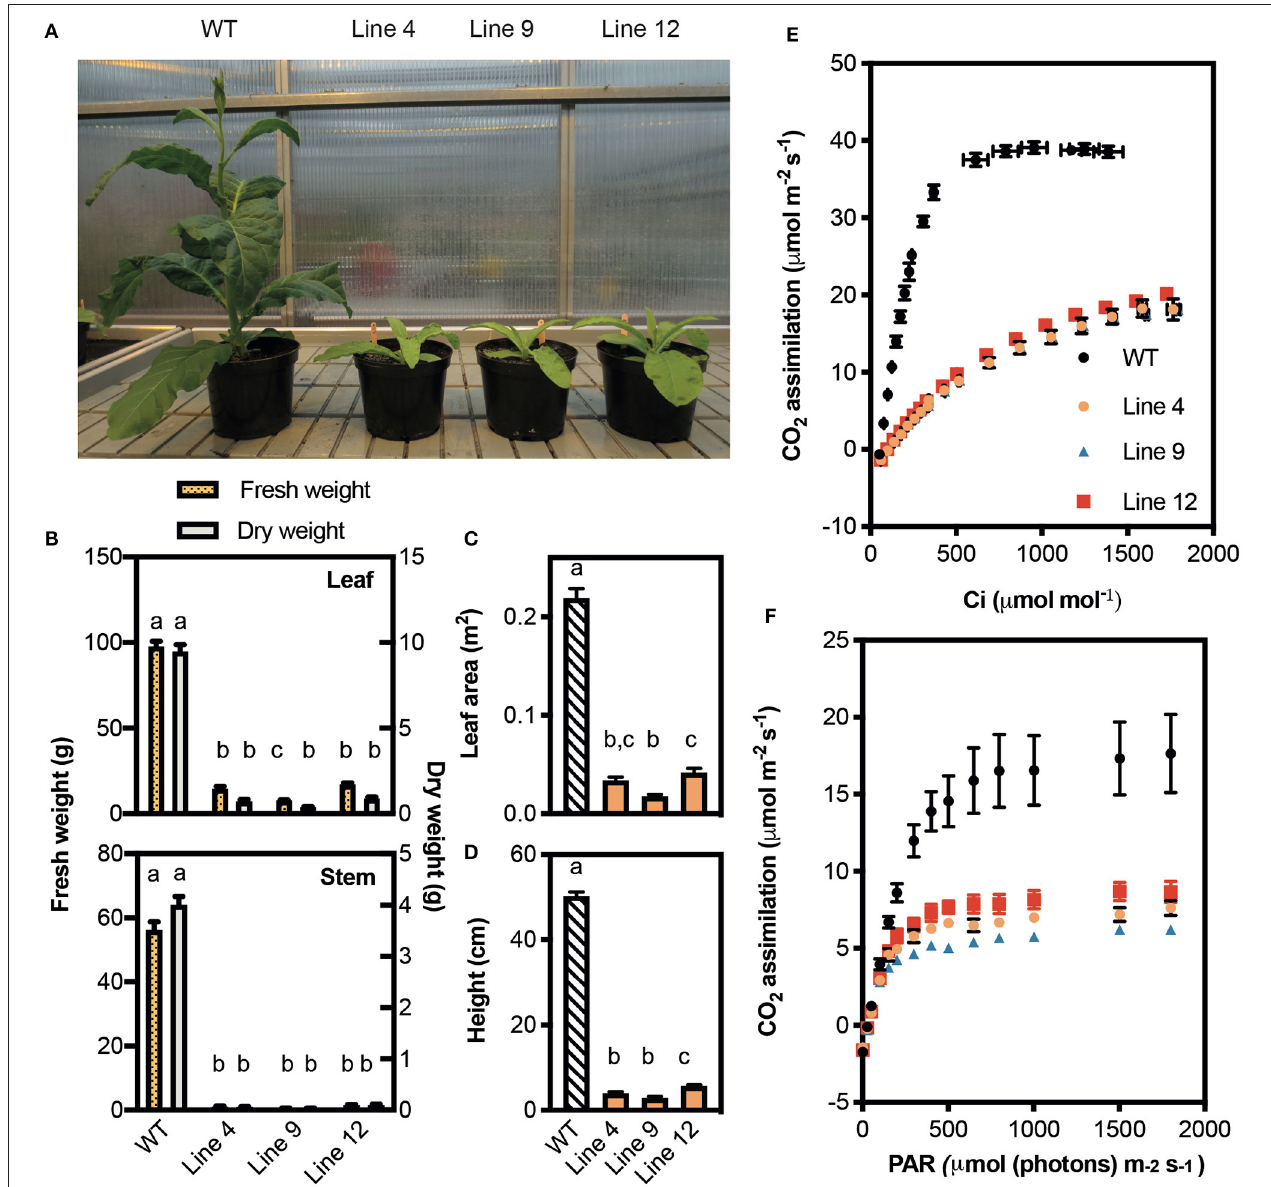
FIGURE 4 | Growth and photosynthetic rates of CRISPR-Cas9 Rubisco mutants in the T 1 generation. (A) Phenotypes of wild-type (WT) and three Rubisco mutant lines after 45 days of growth in a greenhouse with a 15-h photoperiod. (B) Fresh (left y-axis) and dry (right y-axis) weights of leaves (top panel) and stems (bottom panel). (C) Total leaf area and (D) plant height. Growth data show the mean ± SEM ( n = 6–8) with significant differences ( P < 0.05) indicated by different letters determined by ANOVA and Tukey’s HSD tests. (E) The response of A to changing irradiance (PAR) measured at 25 ◦ C under 400 µ mol mol − 1 CO 2 . (F) The response of CO 2 assimilation ( A ) to intracellular CO 2 concentration ( C i ) measured at 25 ◦ C under saturating irradiance (1,500 µ mol photons m − 2 s − 1 ). Each data point represents the mean ± SEM of four leaves each from separate plants ( n =